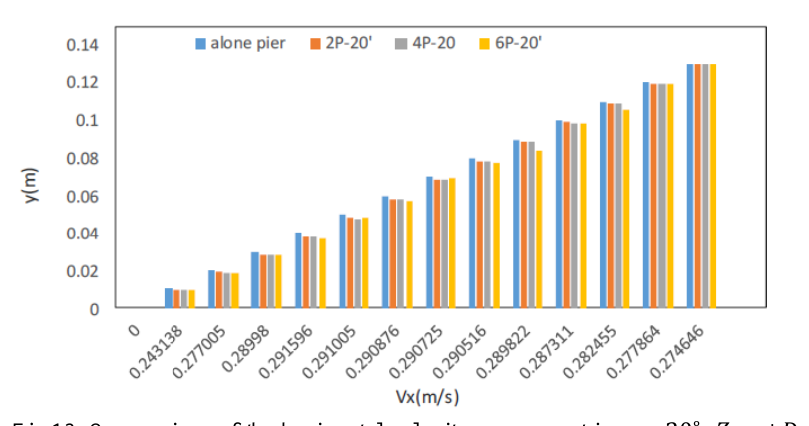
Fig 13. Comparison of the horizontal velocity component in 𝛼 = 20˚ , 𝑍 = +𝐷